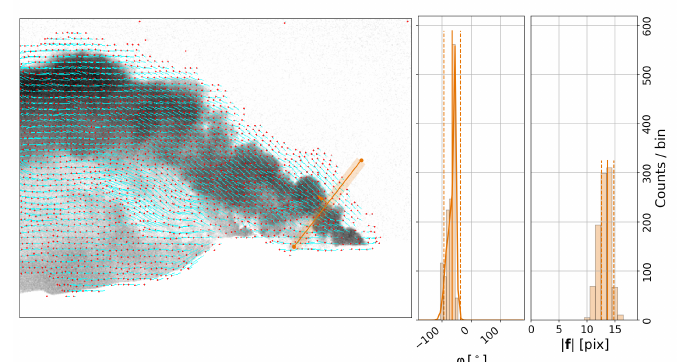
Figure 9. Plume velocity optical flow. Left: example optical flow vector field (blue lines with red dots depicting the movement direction) calculated using the Farnebäck algorithm. Middle, right: histograms of the flow vector orientation angles ϕ and magnitudes | f | , respectively, corresponding to the ROI shown in the left image (semi-transparent rectangular area around the displayed PCS line). From the latter, a plume velocity of 4.2 ( ± 0.4 ) m/s and a predominant movement direction of θ = − 65 ( ± 14 ) ◦ was retrieved using first and second moments of the displayed histogram